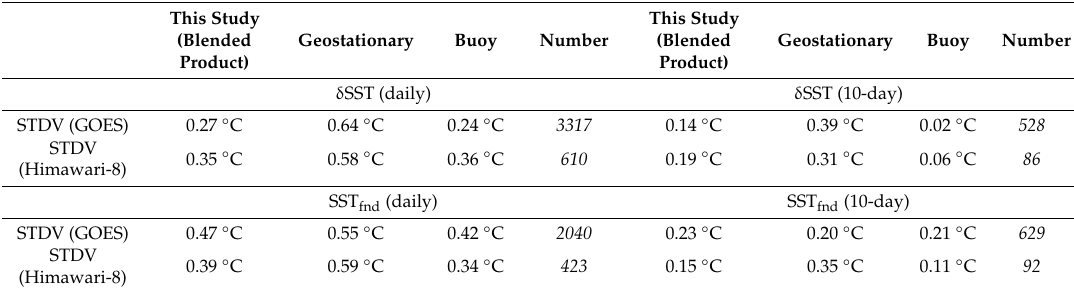
Table 1. Three-way error analysis derived individual satellite and buoy standard deviations (STDV) for diurnal range ( δ SST) and foundation SST (SST fnd ). Italic number shows the collocated match-ups in each